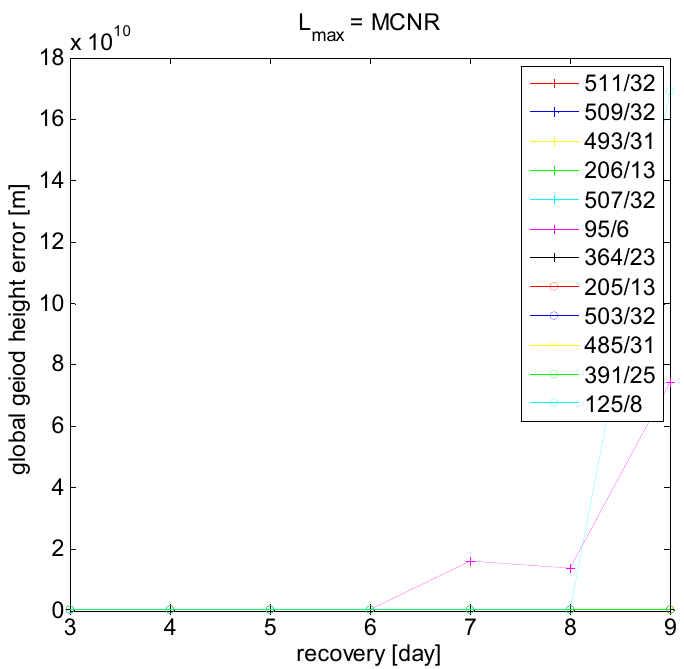
Figure 5. Error RMS in terms of geoid height for the gravity solutions of the Table 1 mission scenarios for maximum spherical harmonic degree and order MCNR.